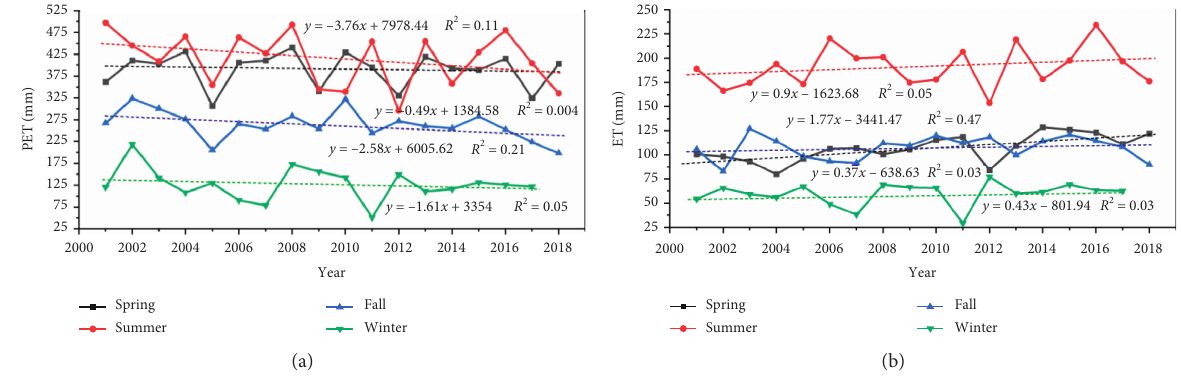
Figure 6: The seasonal changes of PET (a) and ET (b) in the upper Taohe River basin during 2001–2018.